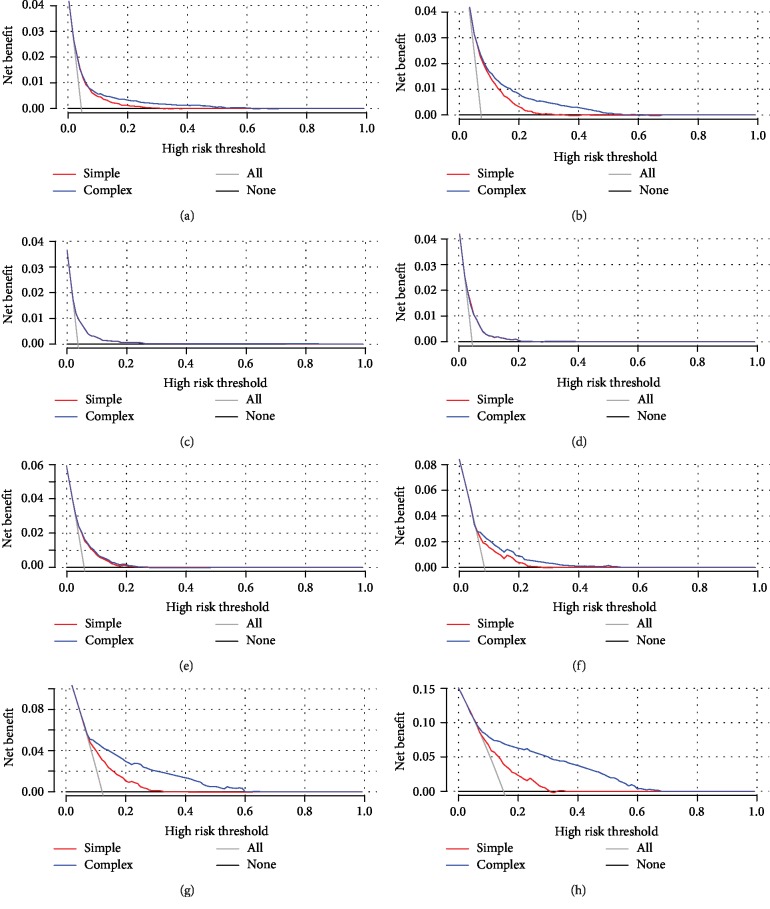
The performance of concise nomogram and comprehensive nomogram scores in the following subpopulations: (a) male, (b) female, (c) 18-29 years old, (d) 30-39 years old, (e) 40-49 years old, (f) 50-59 years old, (g) 60-69 years old, and (h) ≥70 years old.